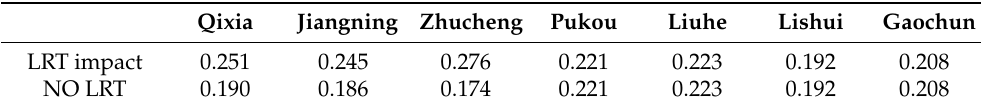
Table 5. Construction land validation (FoM) for various districts, simulated by the proposed and comparative methods.